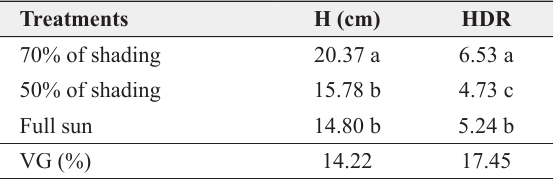
Height (H) and HDR of Myracrodruon urundeuva Allemão seedlings due o different levels of